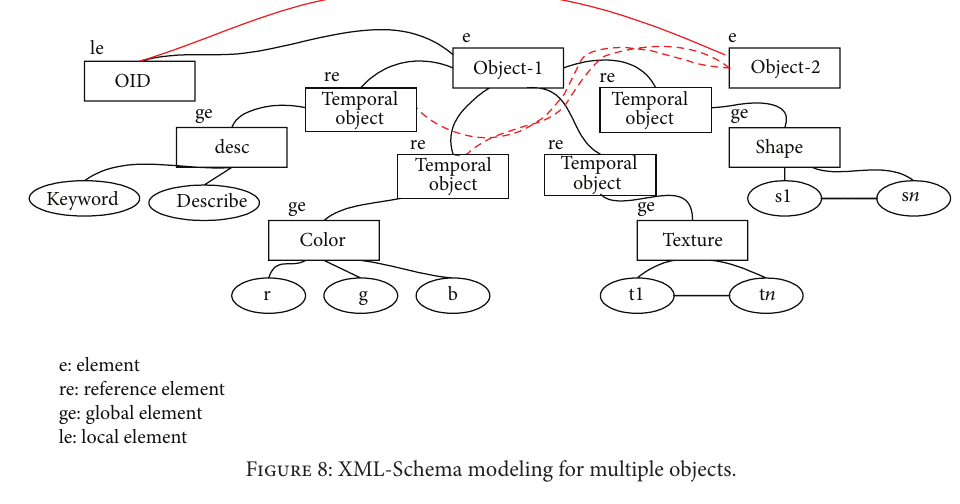
Figure 8: XML-Schema modeling for multiple objects.